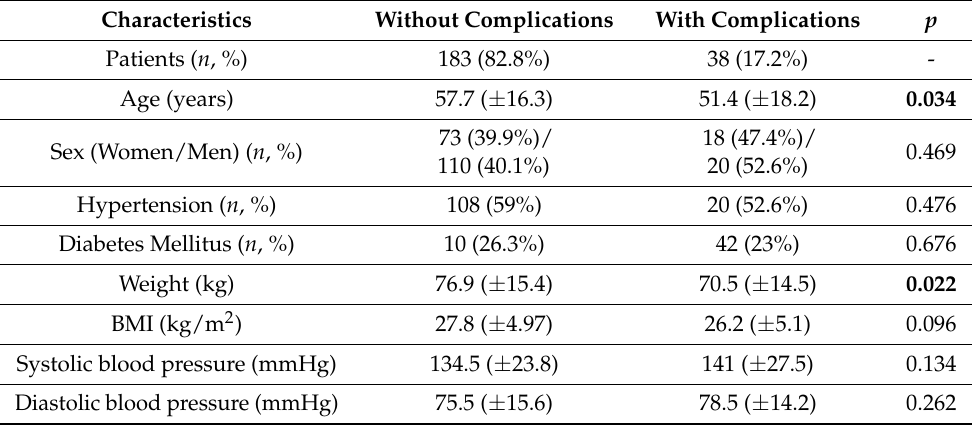
Table 4. Baseline characteristics of patients according to the complications.